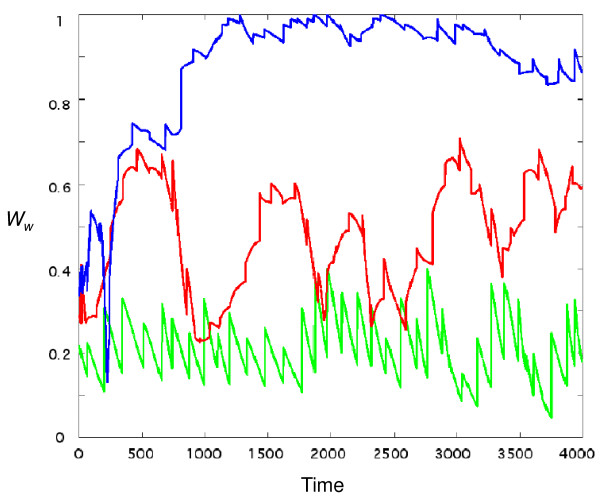
Time dependence of WW for three simulations (σε = 1 green, σε = 3 red, σε = 6 blue). Other parameter values are as in Figure 3. It is seen that the typical WW increases with σε, because higher enantiomeric discrimination (α) values are allowed. The saw-tooth patter arises from growth-fission cycles of the C-GARD assembly.